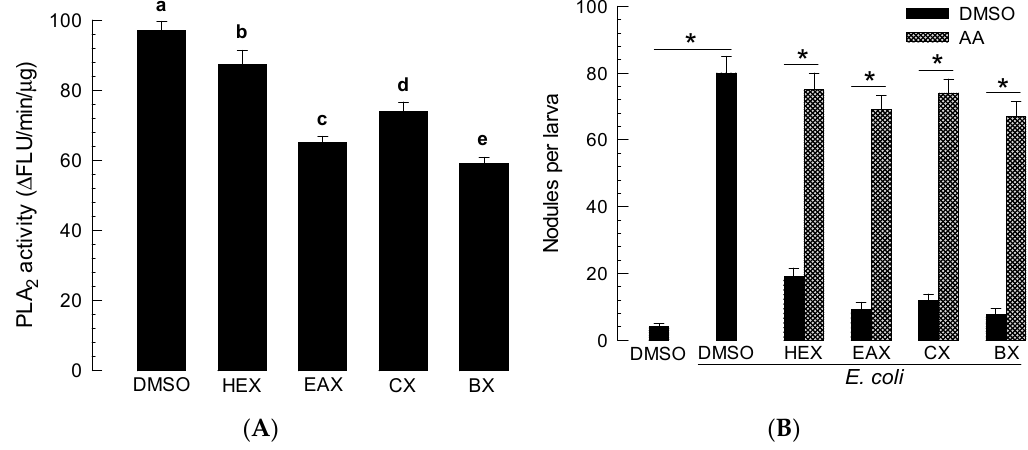
Figure 2. Screening four organic extracts of X. hominickii culture broth. Organic extracts were collected from hexane (HEX), ethyl acetate (EAX), chloroform (CX), and butanol (BX) organic solvents. ( A ) Inhibitory activities of the extracts against hemocyte phospholipase A 2 (PLA 2 ) of S. exigua . ( B ) Inhibitory activities of the extracts against hemocyte nodule formation. Each bacterial extract (1 µL/larva) were injected into L5 larvae along with E. coli (3 × 10 4 cells/larva). Arachidonic acid (AA, 10 µg/larva) was injected along with the extract and E. coli . Dimethyl sulfoxide (DMSO) was used for solvent control. Each measurement was replicated three times with independent samplings. Different letters or asterisks above standard deviation bars indicate significant differences among means at Type I error = 0.05 (least significant difference (LSD) test).